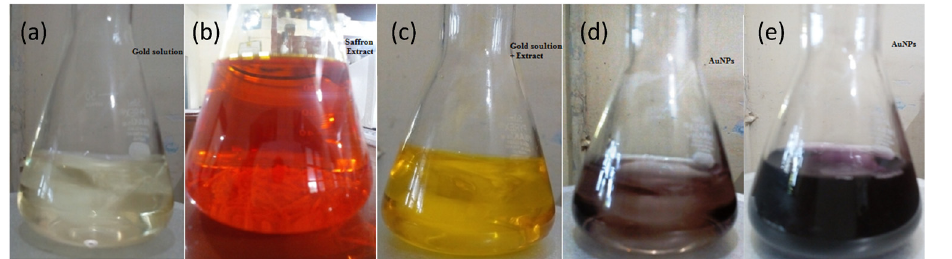
Figure 6: Color change of AuNPs of sa ff ron stigma ( SS - AuNPs ) formation with time: ( a ) sa ff ron extract, ( b ) gold solution, ( c ) initial mixing of gold solution and extract, ( d ) after 30 min, and ( e ) after 1